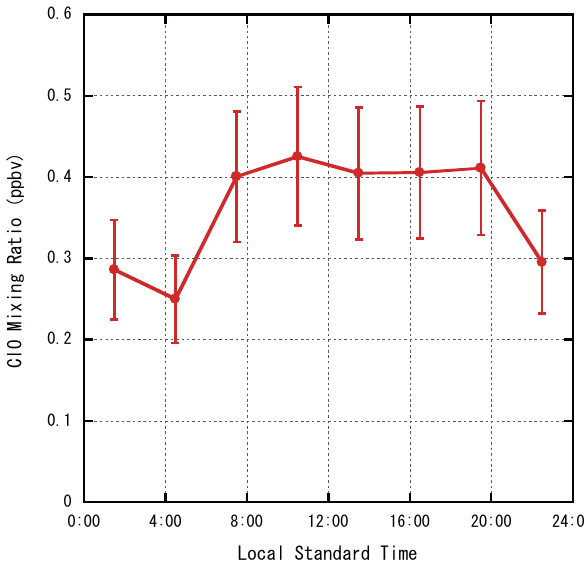
Fig. 10. Diurnal variation of ClO mixing ratio at 40km measured by NATAOS radiometer for a period of 5–16 December